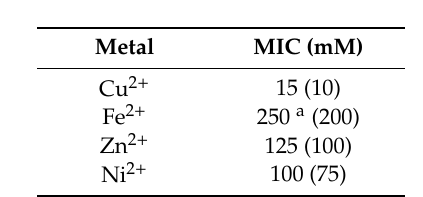
Table 2. Minimum inhibitory concentration (MIC) of some metals (mM) recorded for C. ammoniigenes strain IT2, with the highest concentration at which growth of the bacterium was observed indicated in